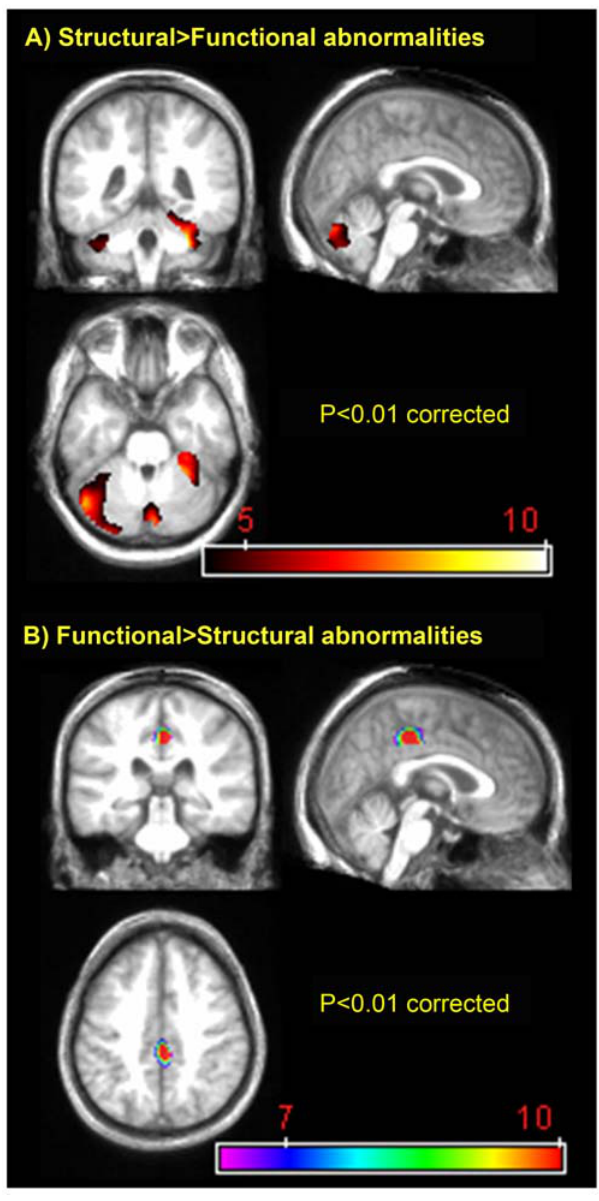
Figure 2. Voxel-based comparison between morphological and metabolism GM abnormalities in Korsakoff’s syndrome ( p , 0.01 FDR; k . 200 voxels). Within group comparisons conducted with the SPM5 paired t-test routine, using z-score maps for hypodensity and hypometabolism. False Discovery Rate correction. On the coronal slice, the right is displayed on the right. The colored bar represents the t value of significant voxels.